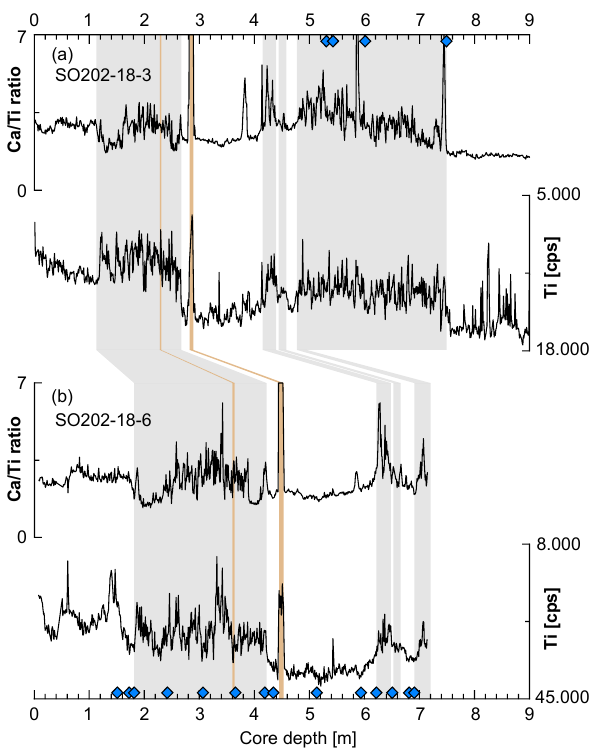
Figure 4. Inter-core correlation between piston core SO202-18-3 (a) and kasten core SO202-18-6 (b) based on XRF-scanning data of the Ca/Ti ratio and Ti concentrations (given in counts per second). Gray bars mark the occurrence of Layered and Laminated Facies; brown bars mark ash layers. Note inverse scale of Ti concentrations. Blue diamonds mark planktic AMS 14 C